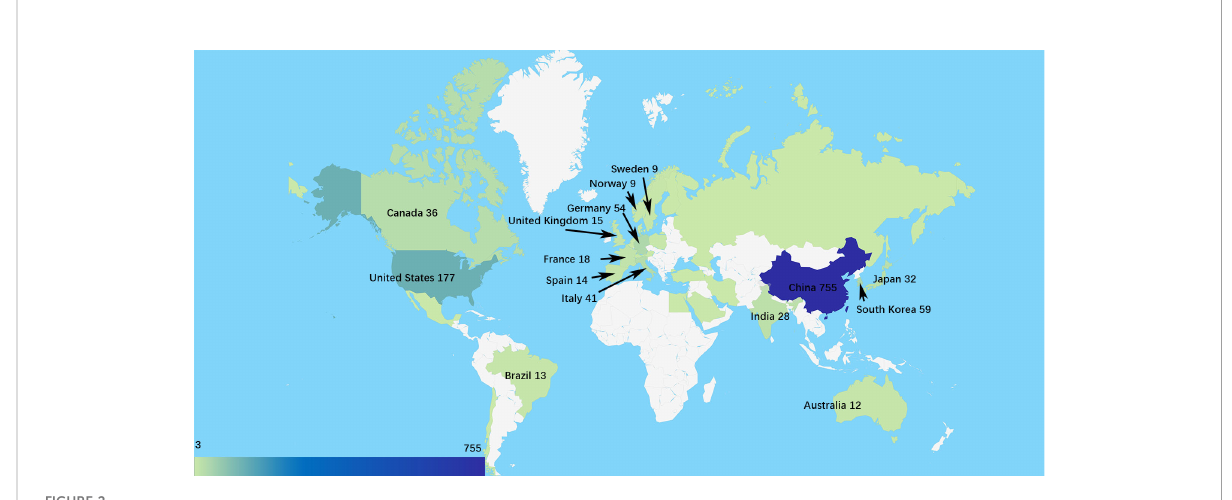
FIGURE 2 The geographical distribution based on the number of publications.